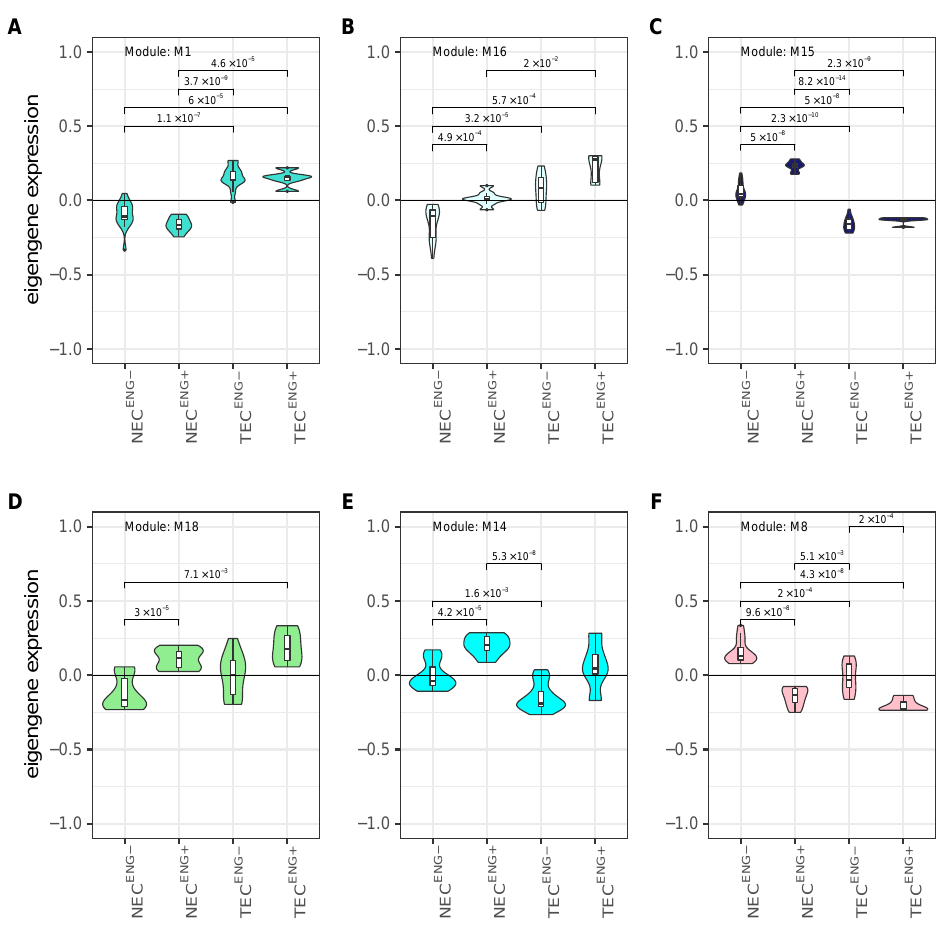
Figure 6. Eigengene plots of modules with strong association to cell origin and angiogenic activation. ( A – C ) Eigengene plots for modules with a strong association to cell origin (M1, M16, and M15). ( D – F ) Eigengene plots for modules with a strong association to angiogenic activation (M18, M14, and M8. Plots are coloured according to the module colour. Numbers represent adjusted p -values for the respective